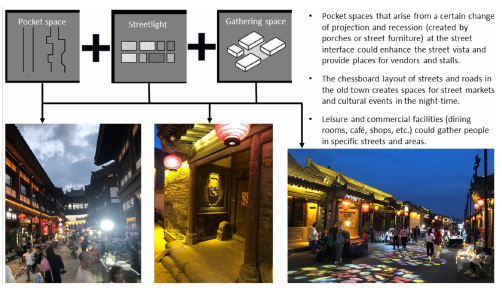
Figure 11. Lights, people attractors, and semi-public spaces help to attract users and conduct night- time activities. Source: Author.